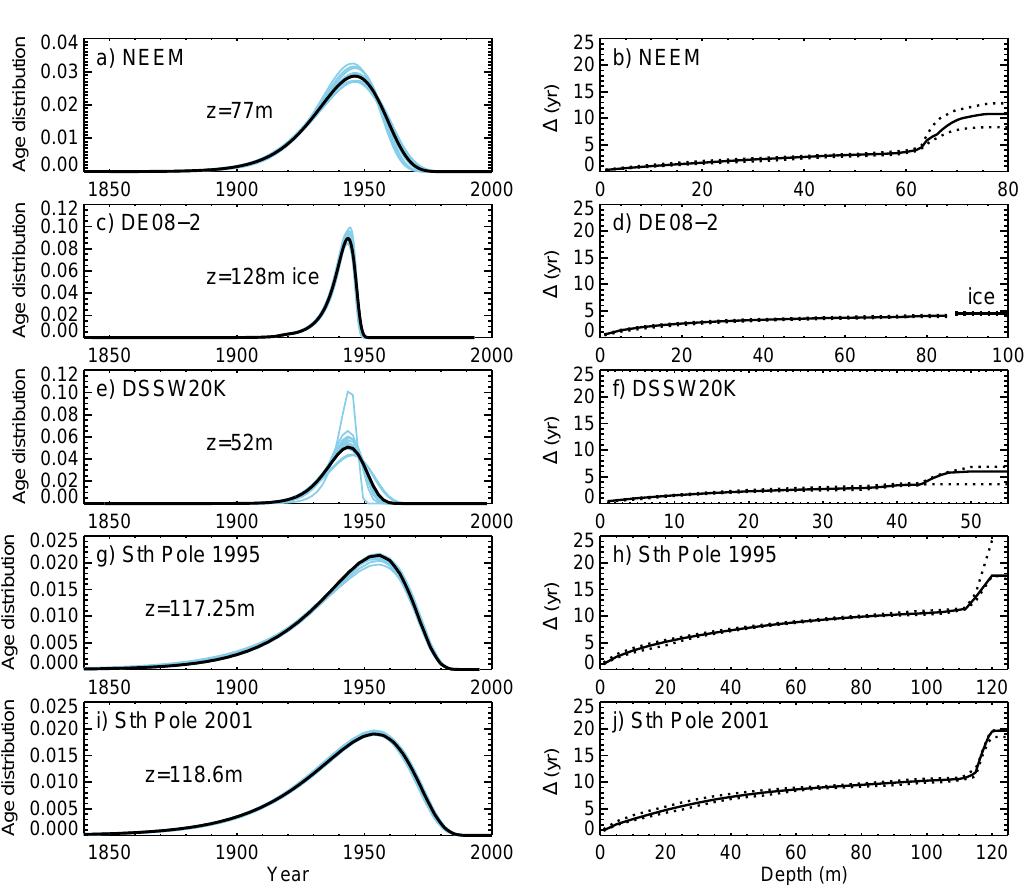
Fig. 13. Plots on the left show CO 2 age distributions for NEEM, DE08-2, DSSW20K, South Pole 1995 and South Pole 2001 corresponding to CO 2 mean ages of 1940. The black lines show the best solution in each case (corresponding to the case with closest match to the reference tracers), and the blue lines show results from 19 representative solutions with diffusivity and other model parameters within the 68% confidence interval for each site. Plots on the right show variation with depth of the spectral width of the CO 2 age distributions, 1 . The black solid lines are the best case and the dotted lines show the upper and lower ranges of estimates from the 19 representative solutions corresponding to confidence intervals of 68%. The age distribution for DE08-2 is for air trapped in bubbles in ice at 128m, and the spectral width plot shows values for the firn to 85m then ice below this. All other cases are for firn air